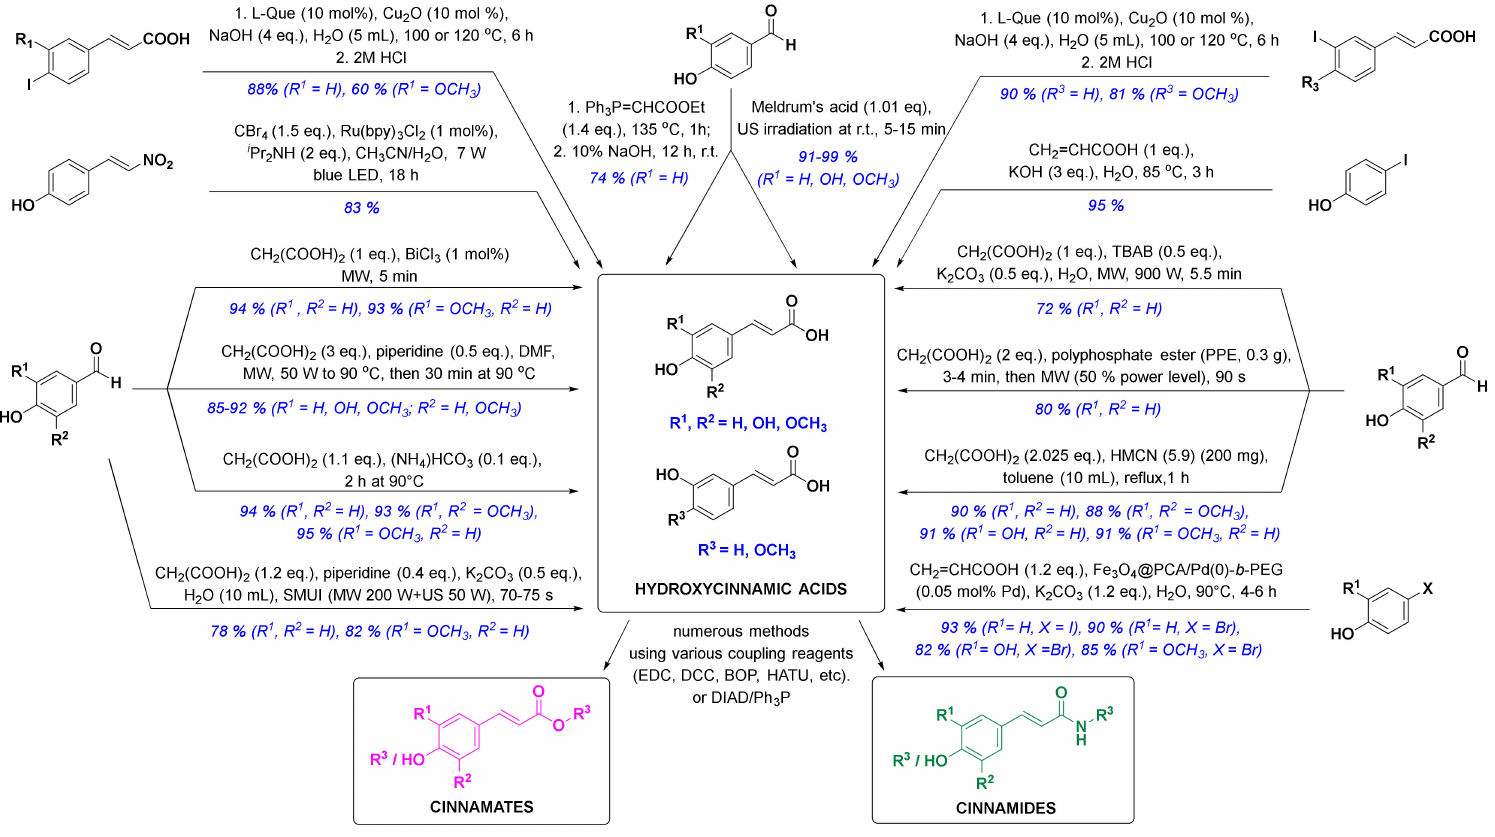
Figure 3. Novel synthetic methods for the synthesis of HCA derivatives (reagents are presented in black, yields and substituents in blue). l -Que, l-( − )-quebrachitol; LED, light emitting diode; MW, microwave irradiation; DMF, dimethylformamide; SMUI, simultaneous microwaves-ultrasound irradiation; US, ultrasound; TBAB, tetrabutylammonium bromide; PPE, polyphosphate ester; HMCN, hexagonal mesoporous carbon nitride; Fe 3 O 4 @PCA / Pd(0)-b-PEG, hyperbranched poly(ethylene glycol)-block-poly(citric acid)-functionalized Fe 3 O 4 magnetic palladium nanoparticles; EDC, 1-(3-dimethylaminopropyl)-3-ethylcarbodiimide; DCC, dicyclohexylcarbodiimide; BOP, benzotriazol-1-yloxy)tris(dimethylamino)phosphonium hexafluorophosphate; HATU, 1-(bis(dimethylamino)methylene)-1 H -[1,2,3]triazolo[4 ,5- b ]pyridine-1-ium 3-oxide hexafluorophosphate; DIAD, diisopropyl